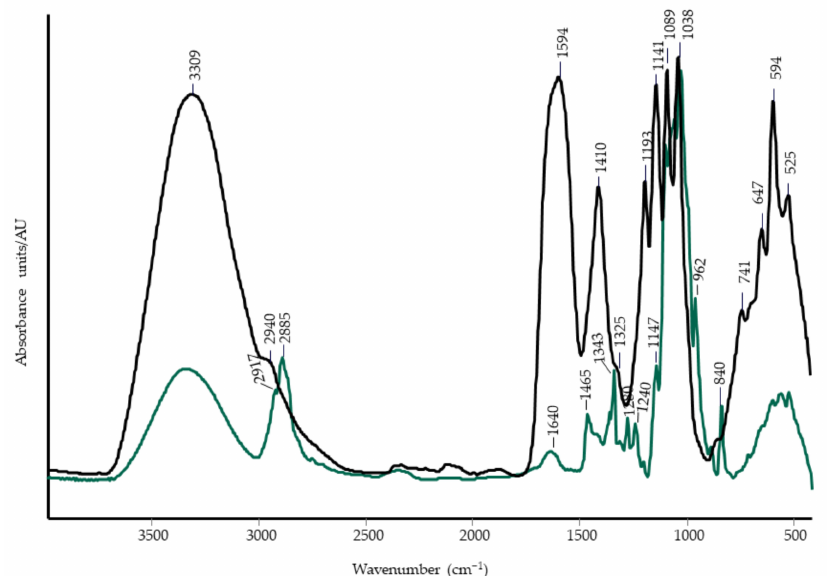
Figure 1. FT-IR spectra of Jania adhaerens water-soluble polysaccharide (black line) and RT a commer- cial product based on laminarin (green